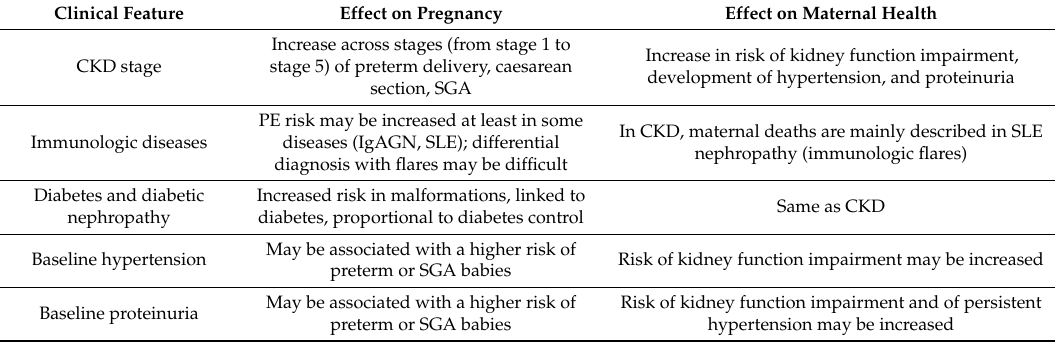
Table 1. Clinical features affecting pregnancy-related risks in CKD